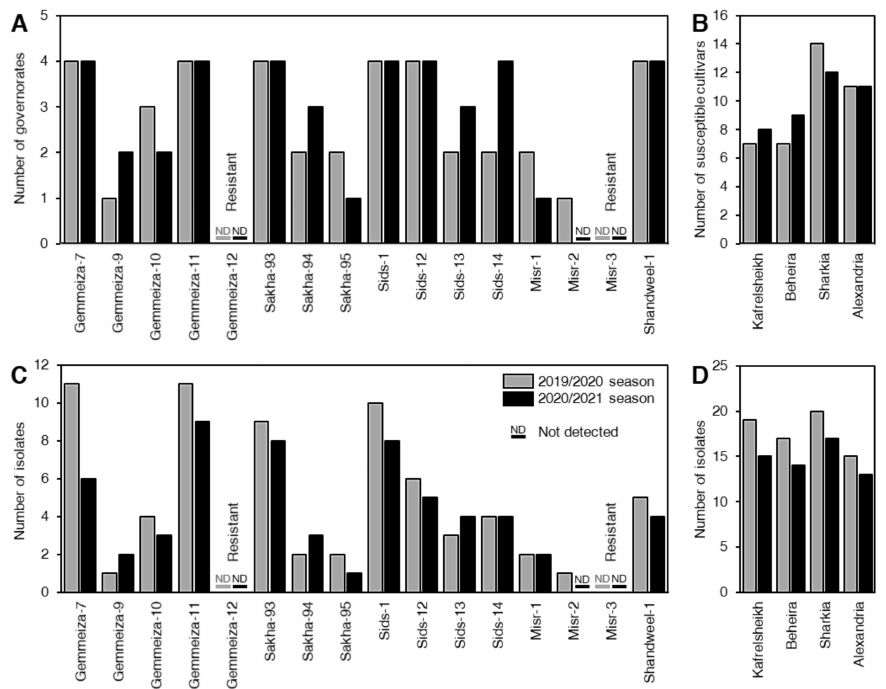
Figure 1. Distribution of P. triticina races in relation to cultivation areas and wheat cultivars. ( A ) Num- ber of governorates that recorded susceptible wheat cultivars, ( B ) number of susceptible wheat cultivars of leaf rust in four different governorates, ( C ) number of P. triticina isolates recorded on 16 Egyptian commercial wheat cultivars, ( D ) number of P. triticina isolates recorded on each